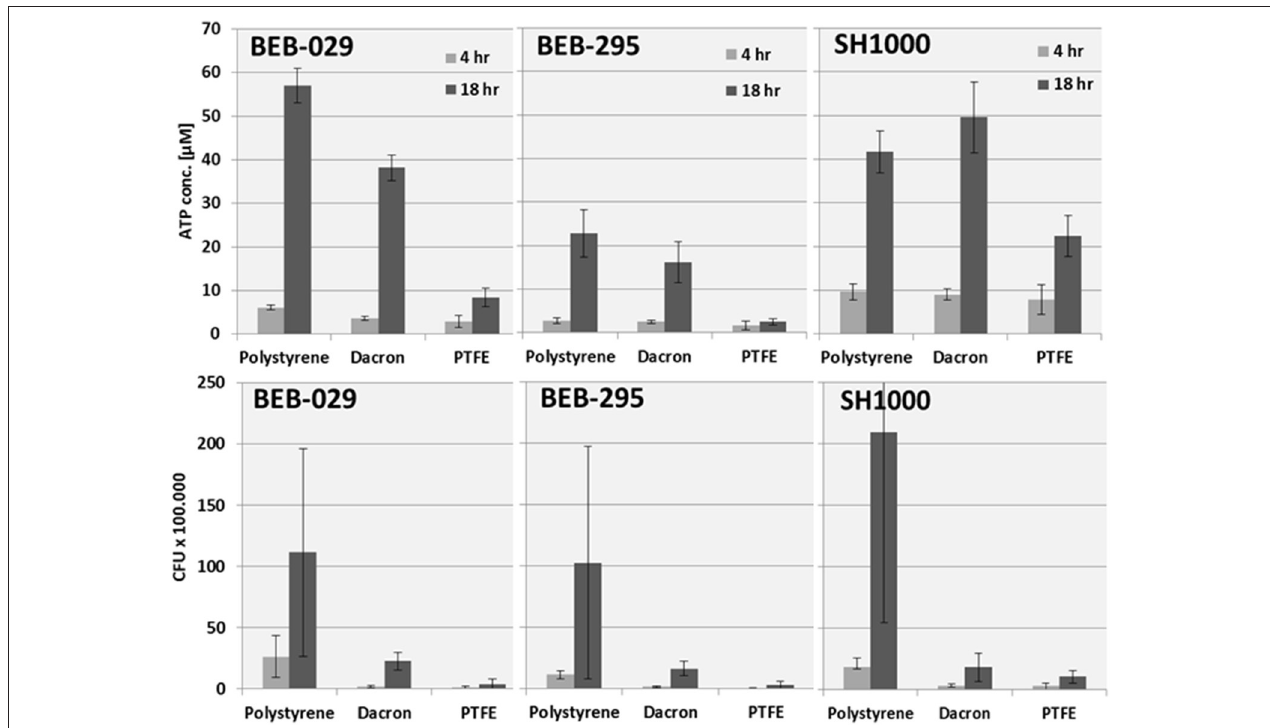
FIGURE 4 | Quantification of the S. aureus strains on different surfaces: polystyrene, Dacron and PTFE. Upper : ATP concentration. Lower : CFU counts. Data for the polystyrene surface were additionally depicted in Figure 3